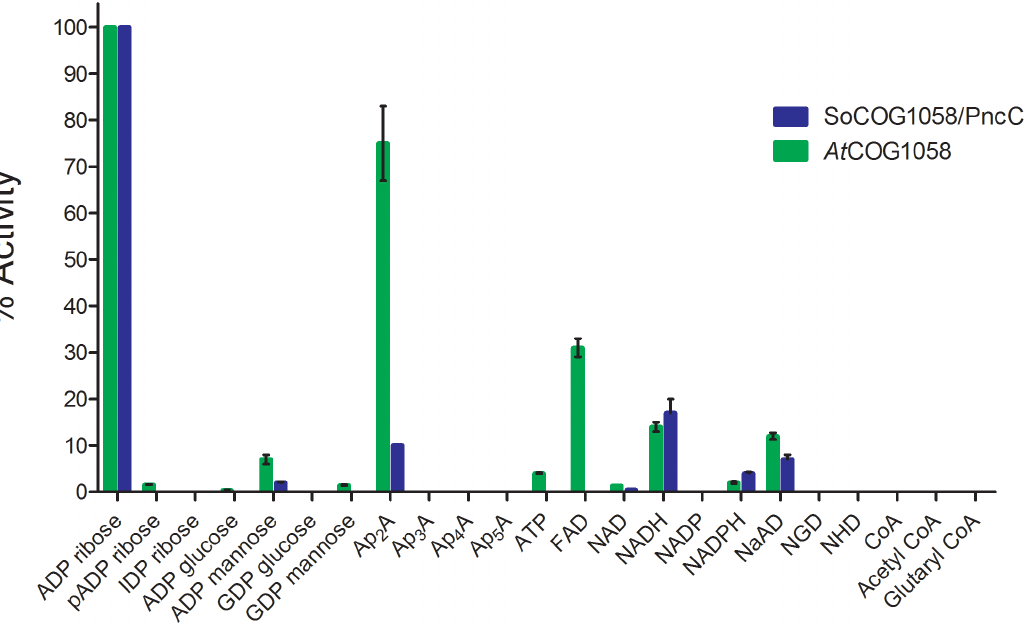
Figure 4. Substrate specificity screening of At COG1058 and So COG1058/PncC pyrophosphatases. The pyrophosphatase activity of the pure recombinant enzymes was assayed as described in ‘‘Materials and Methods’’, in the presence of the listed compounds at 0.5 mM concentration each. Abbreviations: Ap 3 A, diadenosine triphosphate; Ap 4 A, diadenosine tetraphosphate; Ap 5 A, diadenosine pentaphosphate; NGD, nicotinamide guanine dinucleotide; NHD, nicotinamide hypoxanthine dinucleotide.